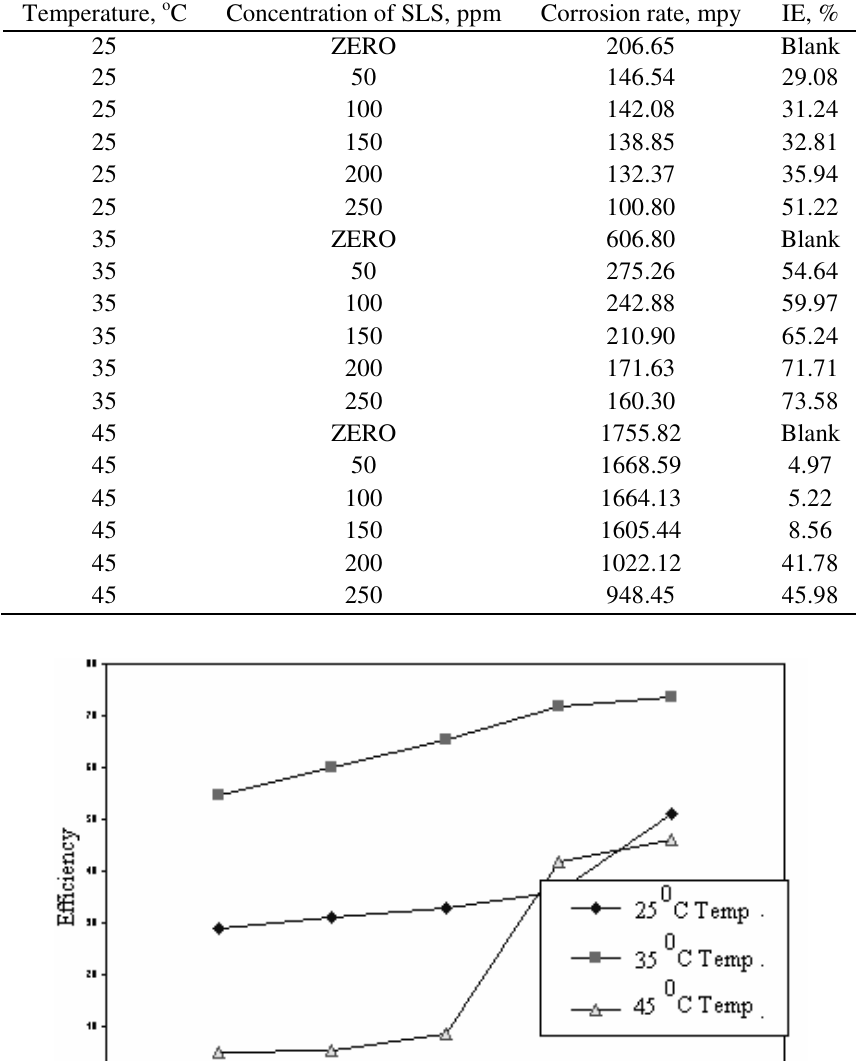
Table 1. Inhibition efficiencies (IE) obtained from weight loss data in 1 M HCl solution in presence and absence of Sodium Lauryl Sulfate (SLS) at different temperatures.